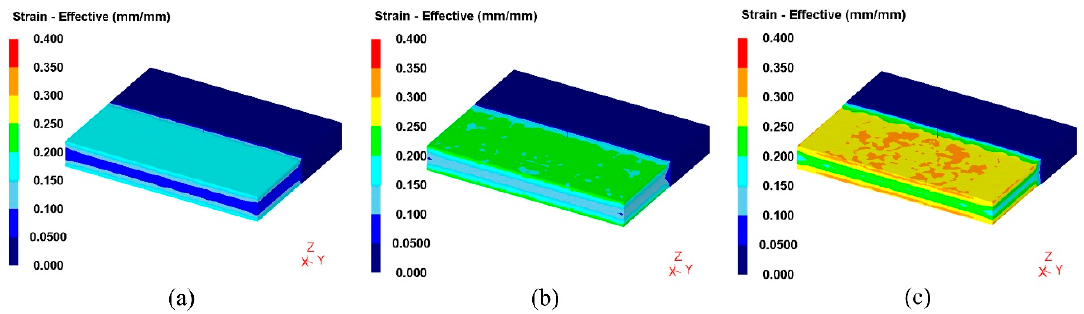
Figure 6. Distributions of temperature and temperature gradient along the directions of thickness and width before the HHR 2 process: ( a ) thickness z = 0; ( b ) width y = 0. width before the HHR 2 process: ( a ) thickness z = 0; ( b ) width y = 0.